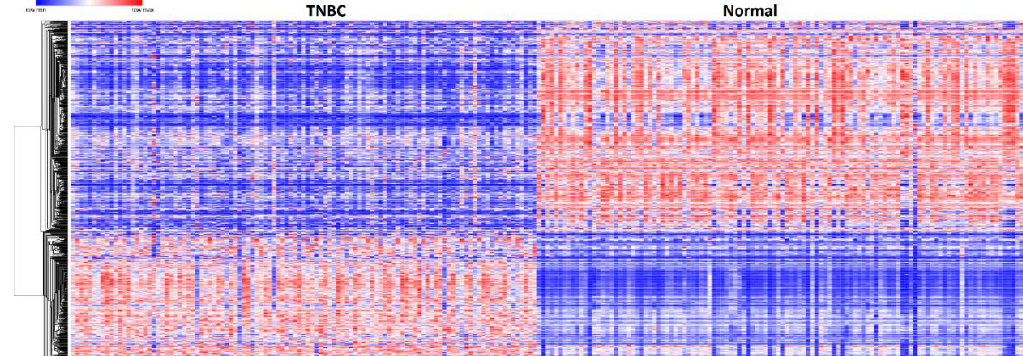
Figure 3. Patterns of gene expression profiles for the 237 up and downregulated genes containing both germline and somatic mutations found to be significantly ( p < 0.05) differentially expressed between patients with TNBC and control samples. Red color represents upregulation; blue color represents downregulation.